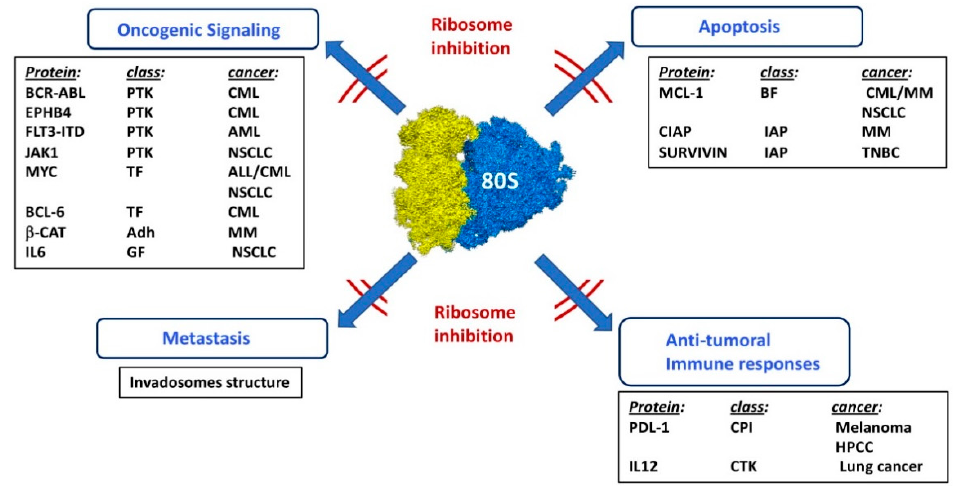
Figure 5. Effects of ribosome inhibition in various cancer models. Combination of ribosome inhibition with other chemotherapeutic treatments. PTK: protein tyrosine kinase, TF: transcription factor, Adh: adhesion molecule, GF: growth factor, BF: BCL-2 family, IAP: inhibitor of apoptosis, CPI: check point inhibitor, CTK: cytokine, CML: chronic myeloid leukemia, AML: acute myeloid leukemia, NSCLC: non-small cell lung carcinoma, MM: multiple myeloma, TNBC: triple negative breast cancer, HPCC: hepatocarcinoma.